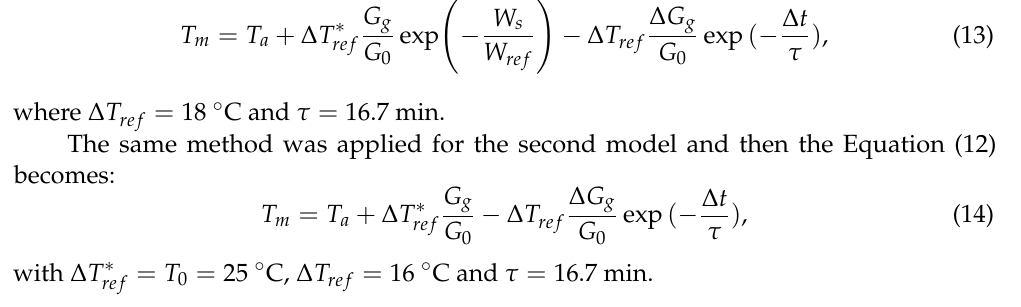
Table 5. The sample size of measurements in different time steps for three regions in Vietnam.